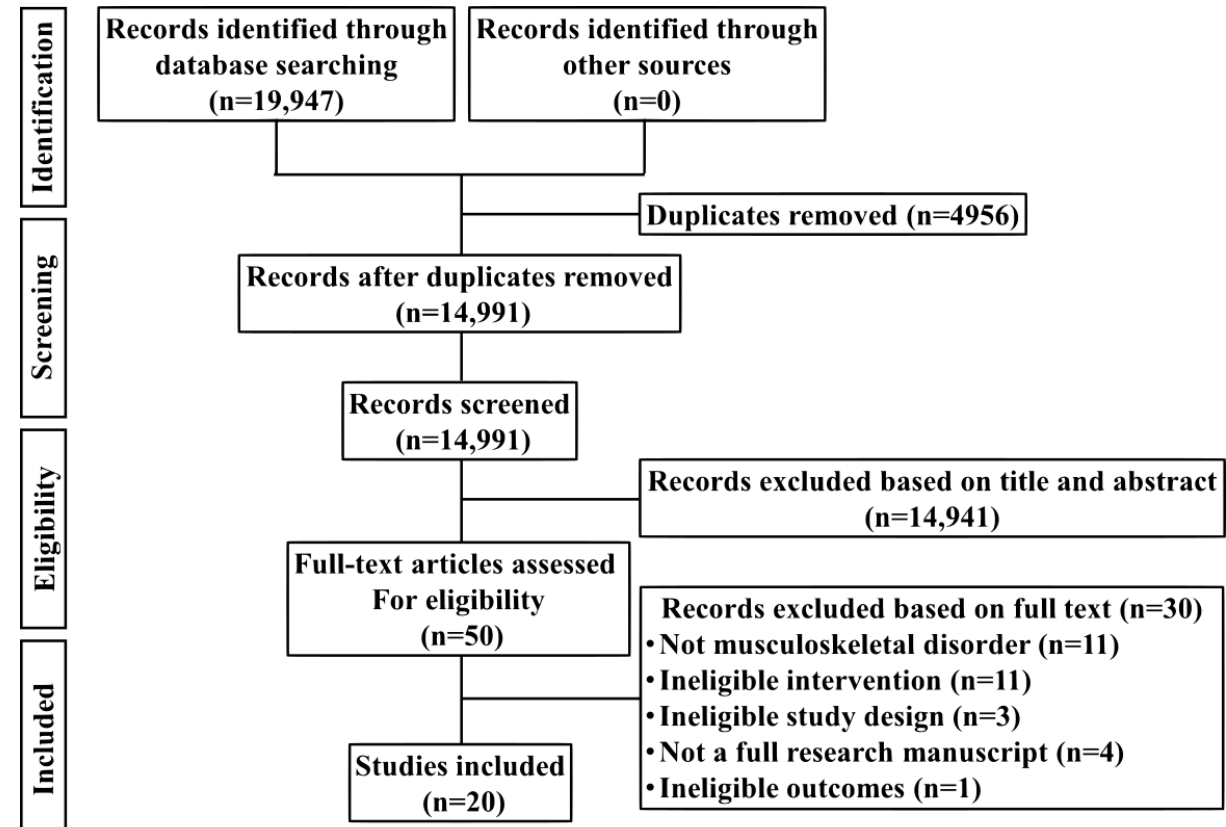
Figure 1. Study eligibility